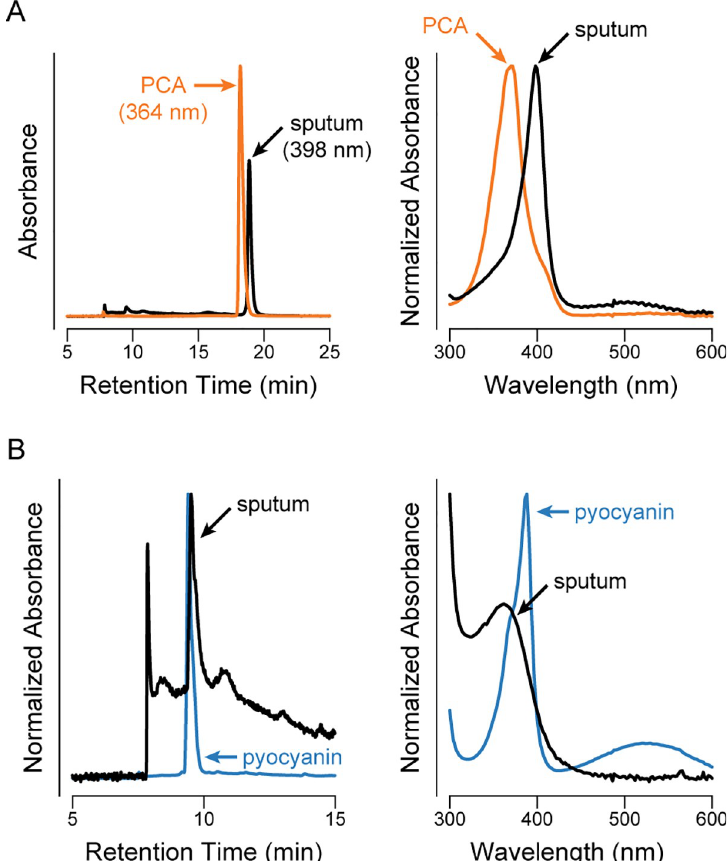
Fig 2. Re-analysis of HPLC peaks previously assigned as phenazines from original data collected on an older HPLC. UV–vis chromatograms are shown on the left, and the full UV–vis spectra of the peaks indicated with an arrow are shown on the right. Where indicated on the y -axis, the data have been normalized to bring the data into the same scale for clarity. (A) Analysis of the PCA peak, comparing a pure PCA standard (chromatogram at 364 nm, orange) to a sputum sample (chromatogram at 398 nm, black). (B) Analysis of the pyocyanin peak, comparing pyocyanin in P . aeruginosa -free sputum (blue) to a P . aeruginosa -positive sputum sample (black) (both chromatograms at 387